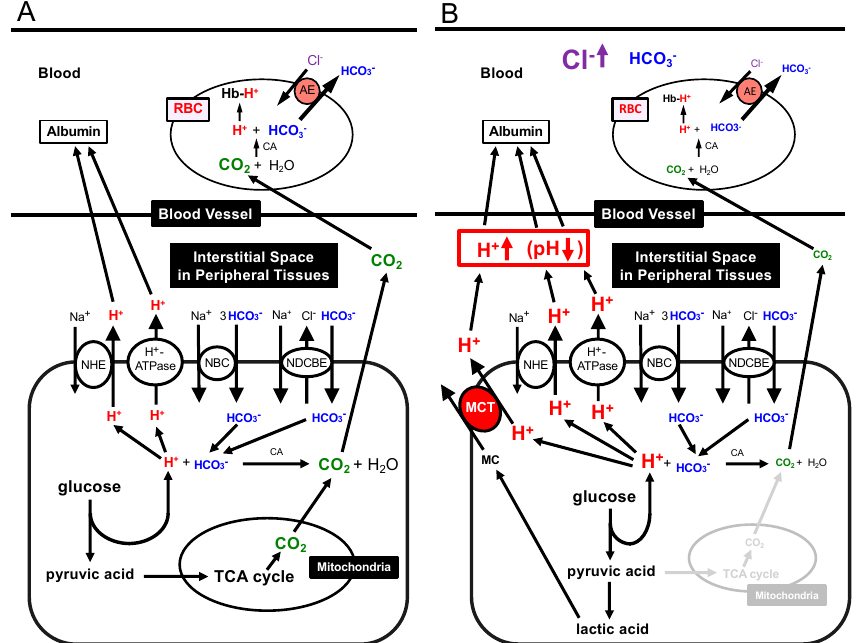
Figure 1. Production of H + and CO 2 , and transporting systems of H + and CO 2 in peripheral tissues. ( A ) Production of H + and CO 2 , and transporting systems of H + and CO 2 in peripheral tissues with ‘normal’ mitochondrial function: the glycolysis process produces H + and TCA cycle generates CO 2 . ( B ) Production of H + and lactic acid, and transporting systems of H + and lactic acid in peripheral tissues with ‘dysfunction’ of mitochondria such as MM and DM cells. Much more amounts of H + are produced via glycolysis in a case of mitochondrial dysfunction, MM and DM cells in order to produce the same amount of ATP as that with normal mitochondrial function. In a case of mitochondrial dysfunction such as MM and DM cells, TCA cycle has no or little function, thus the required amount of ATP is mainly generated via glycolysis, leading to production of much more amounts of H + and lactic acid than that of the normal mitochondrial function. Modified from Figure 3 in Int. J. Mol. Sci. 2018, 19, 3244 [48].